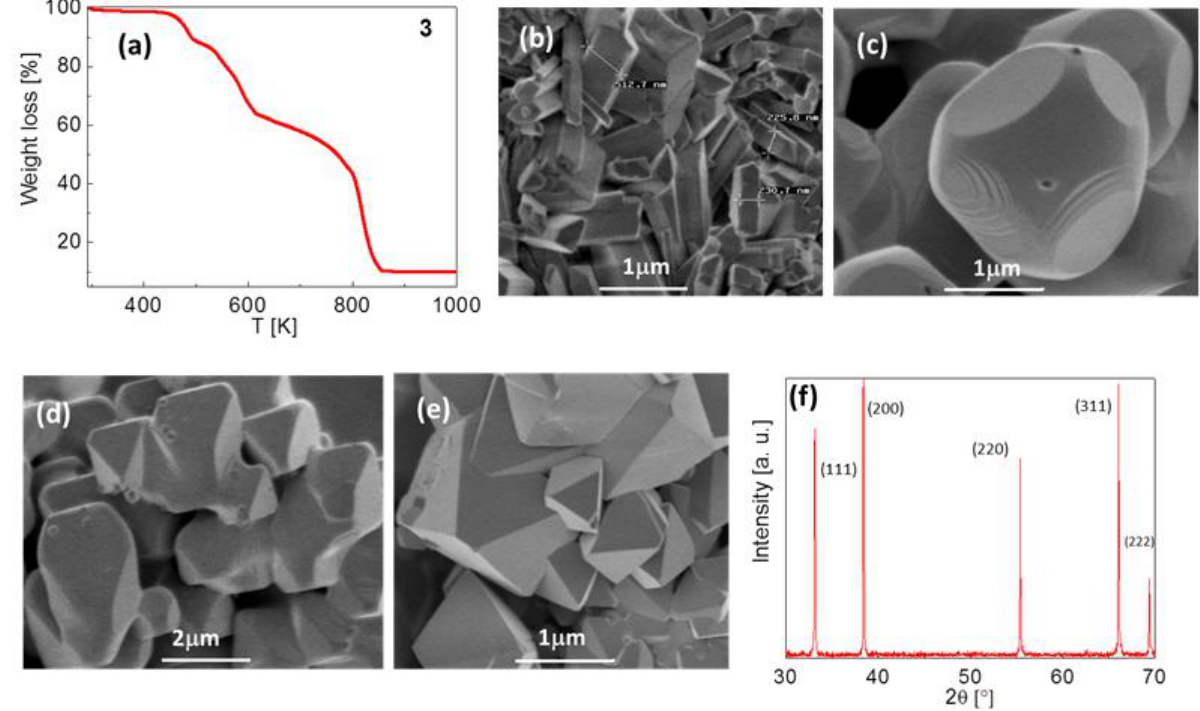
Figure 7. ( a ) TGA pattern of 3 , (b–e) Morphology of CdO crystals obtained at different conditions of pyrolysis: ( b ) rectangle blocks ( white residue of CdO ) ( c ) truncated octahedra ( d ) hexagonal blocks ( e ) octahedron ( f ) PXRD of red form of CdO ( β -form) [55]. Adapted with permission from [55]. Copyright 2011 American Chemical